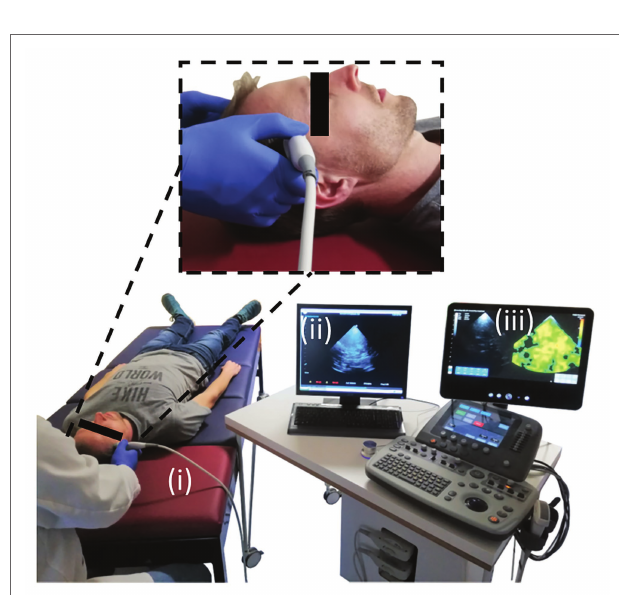
FIGURE 2 | Experimental setup for conduct of cerebral THE. The setup comprised of three main components: (i) the customized patient bed with the vibration plate (red), (ii) the clinical ultrasound scanner, and (iii) the elastography computer with the integrated post-processing software. The magnification shows the positioning of the ultrasound probe over the volunteer’s temporal bone window for transcranial